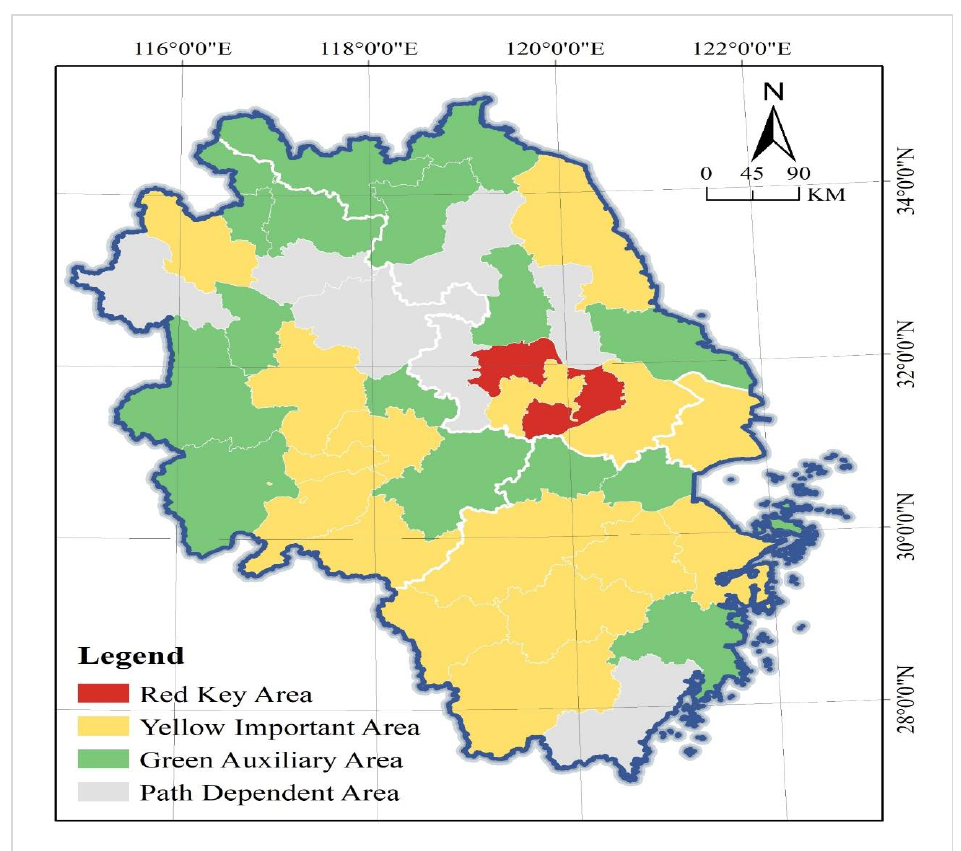
Figure 12. The policy zoning of real estate inventory management in Yangtze River Delta. Table 6. The benchmark suggestions of real estate inventory in the Yangtze River Delta.